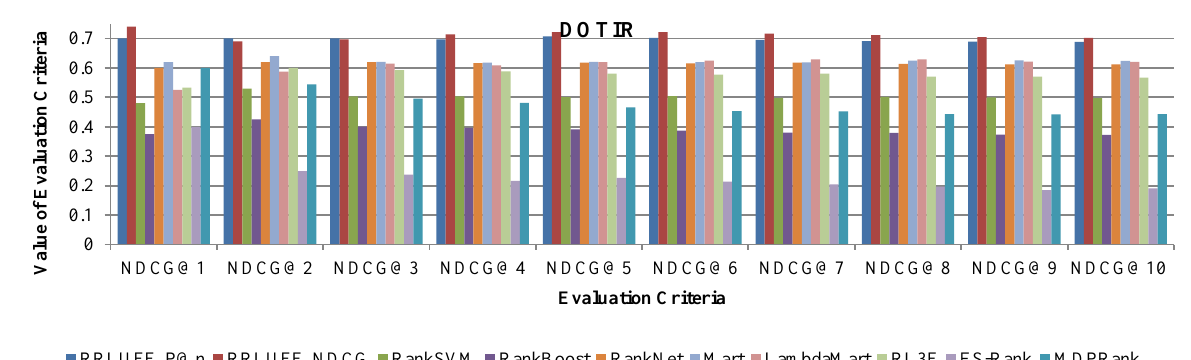
Figure 7. Comparison between the proposed algorithm and algorithms expressed regarding the evaluation criterion NDCG@n on DOTIR